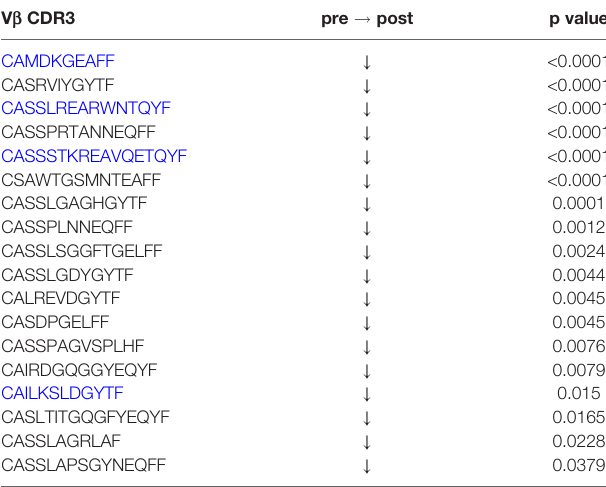
TABLE 4 | Decrease in frequency of the top 50 brain clonotypes in post-surgery blood. V b CDR3